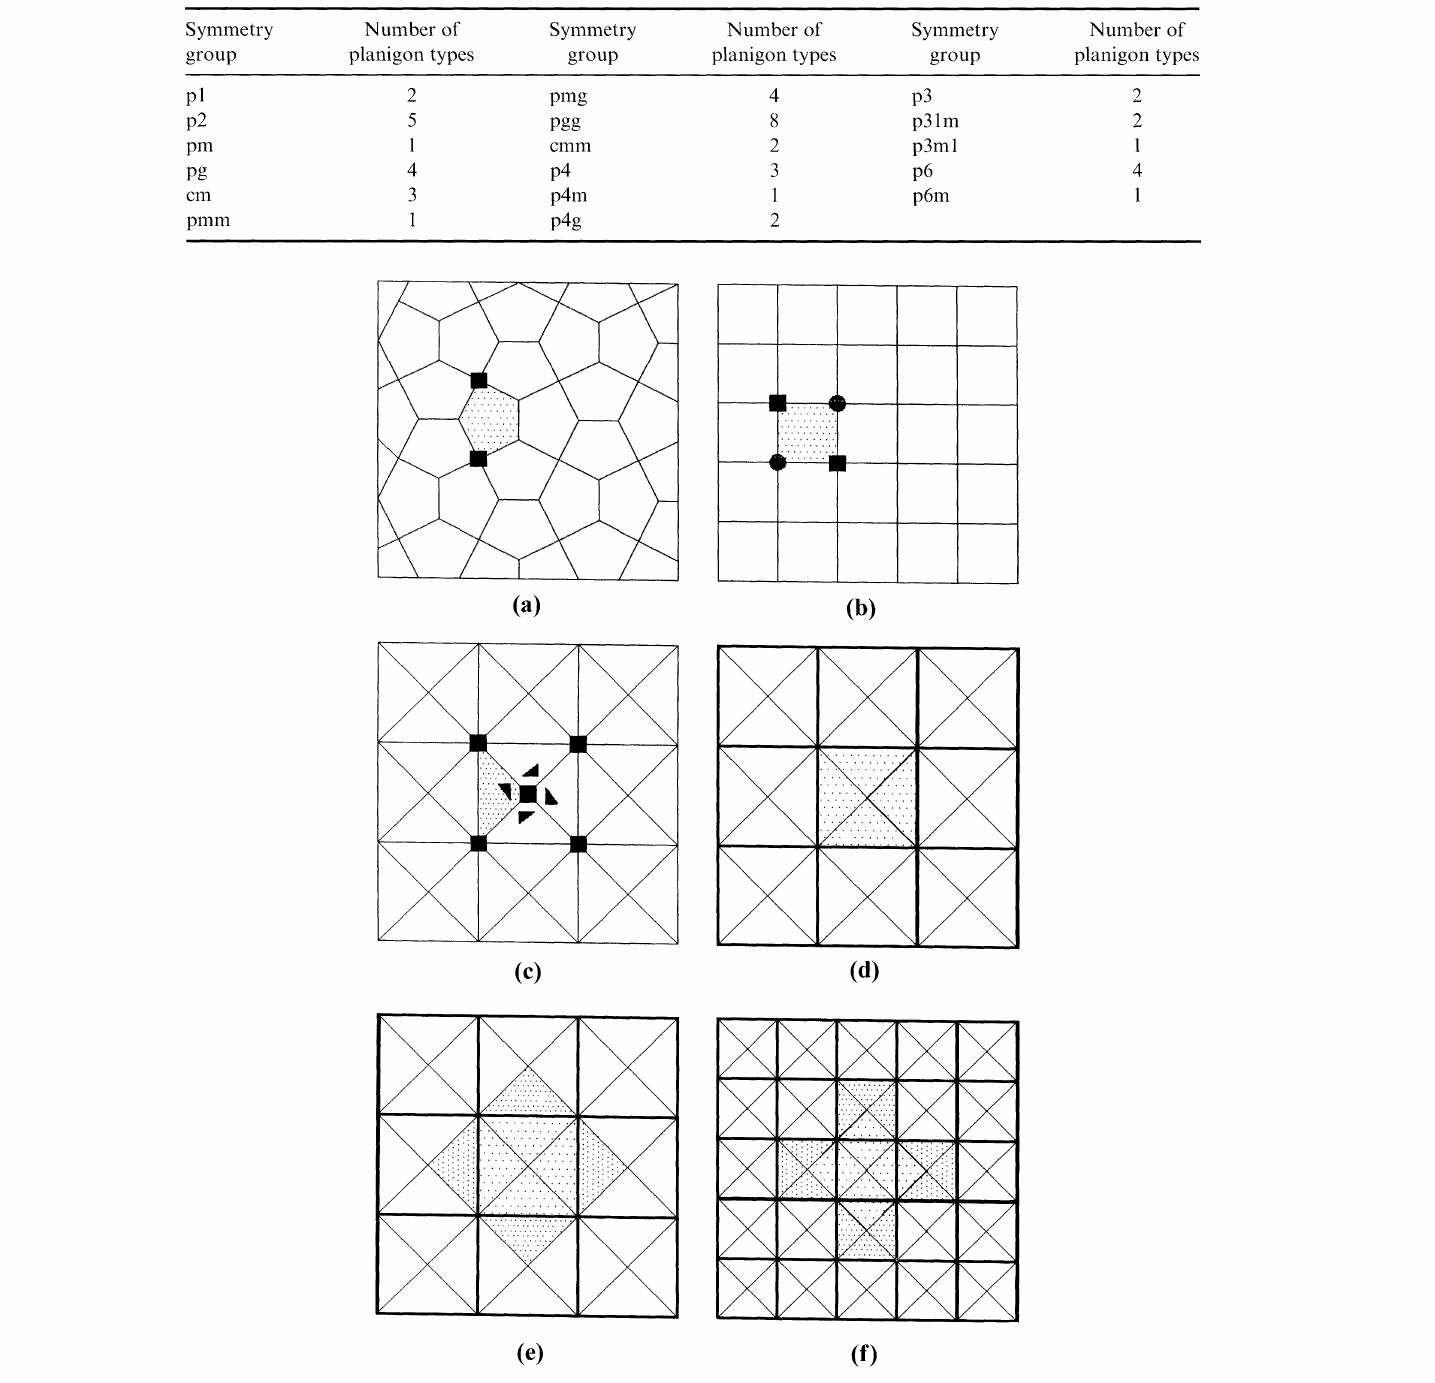
FIGURE 3 (a)-(c) Three different planigon tessellations for p4 symmetry group, filled quadrangles denote tetrad symmetry axes, filled triangles are asymmetric crystallographic points and show the centers of action of planigons; (d) the superposition of the planigon tessellation (c) and corresponding Wigner-Seitz tessellation; (e,f) first steps of the evolution of a PTCA according to the rule described in the